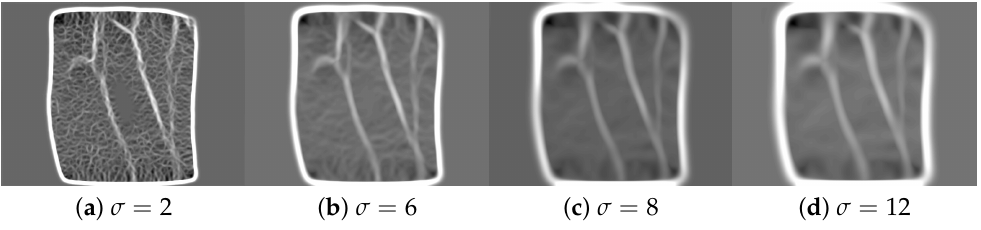
Figure 3. Hessian images of the veins at different